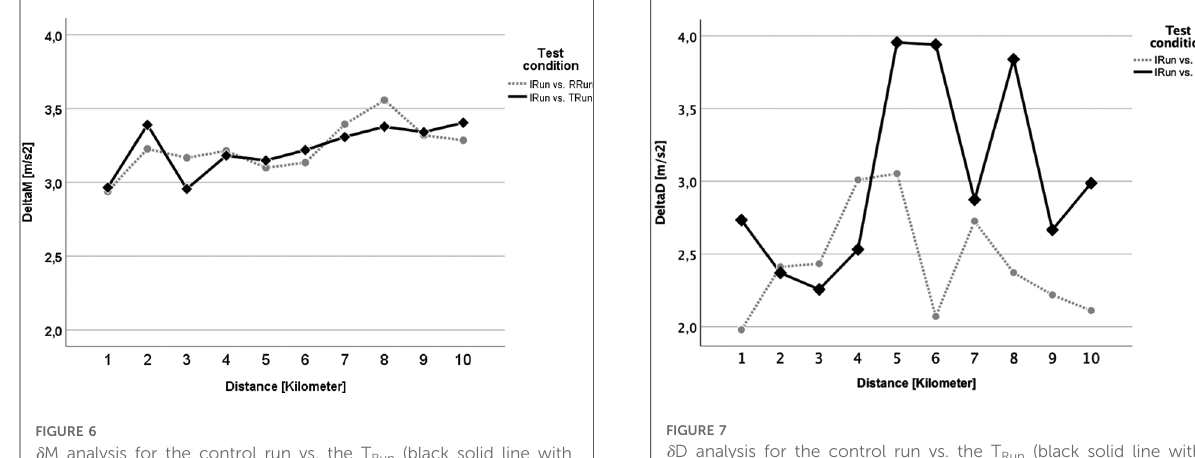
Run (black solid line with